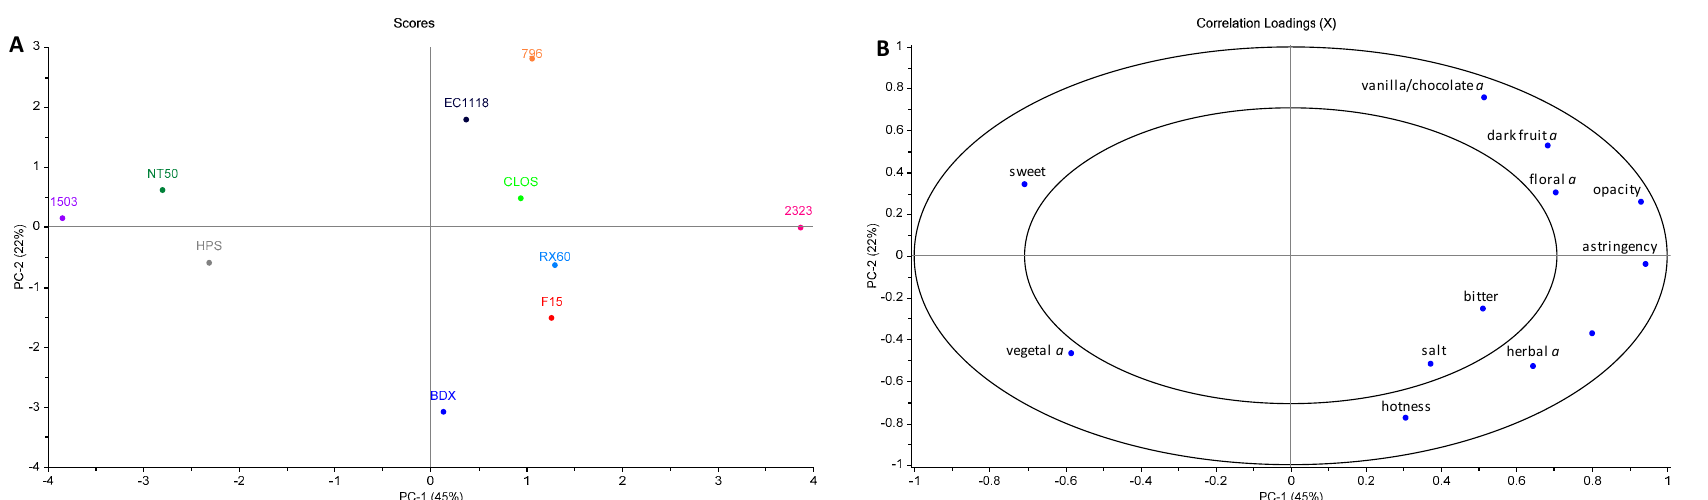
Figure 2. Principal component analysis of the composition of wine sensory attributes determined for duplicate wines prepared using 10 commercial yeast strains ( A ) Scores plot showing each yeast strain as a different colour; ( B ) Correlation loadings plot for wine sensory attributes (aroma variables designated a). Table 6. Partial least squares (PLS1) regression analysis of the wine sensory attributes opacity and astringency (Y) showing the total principal component (PC) number in the model, R ‐ squared values for calibration (cal) and validation (val), root mean squared error of prediction (RMSE) and the explained variance (%) for all compositional X variables, and sub ‐ sets of significant X variables.